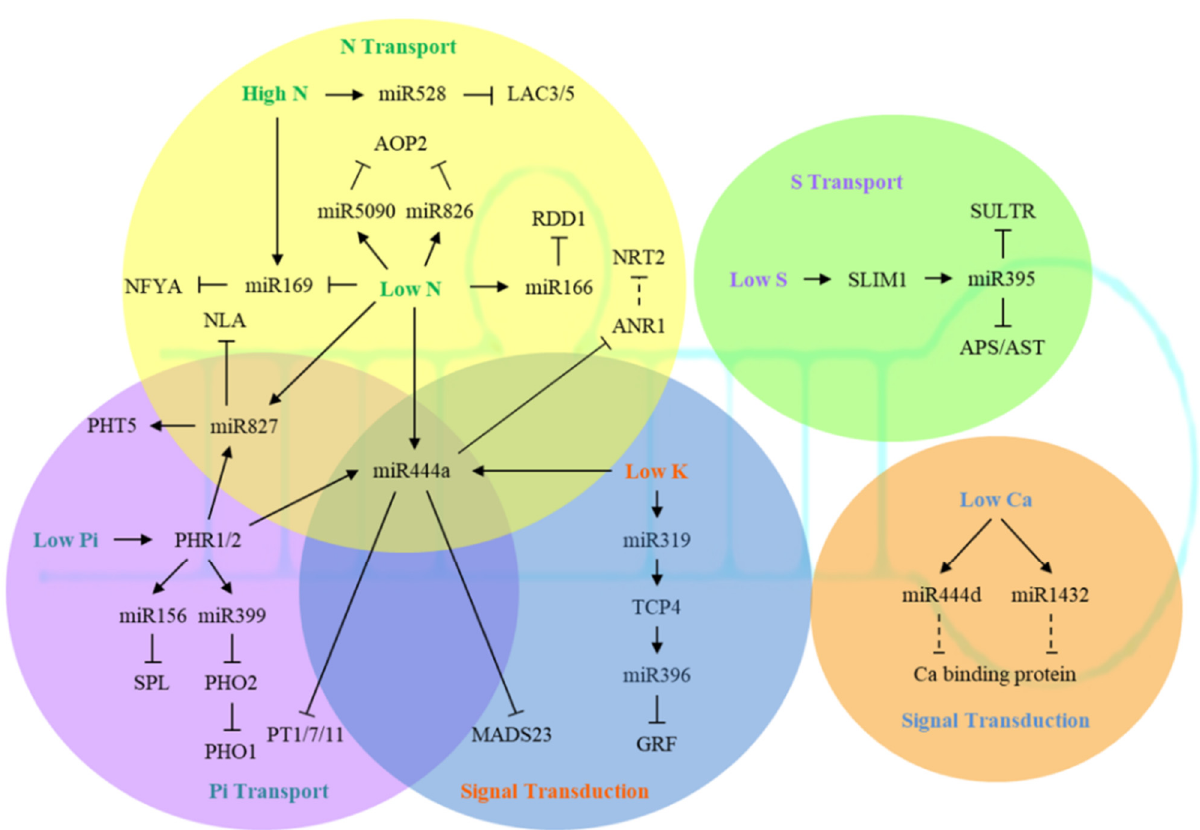
Figure 1. The miRNA-mediated regulatory network for plant responses to macronutrient stress. The miRNAs in the yellow, purple, blue, green, and orange circles are involved in response to stress of nitrogen (N), phosphorus (P), potassium (K), sulfur (S), and calcium (Ca), respectively. Notably, miR827 is responsive to both N and P stresses, while miR444a is responsive to N, P, and K stresses. The dotted line refers to the putative relation between miRNA and its target based on their opposite expression changes. The target genes of nutrient-responsive miRNAs are mainly involved in nutrient transport and signal transduction.